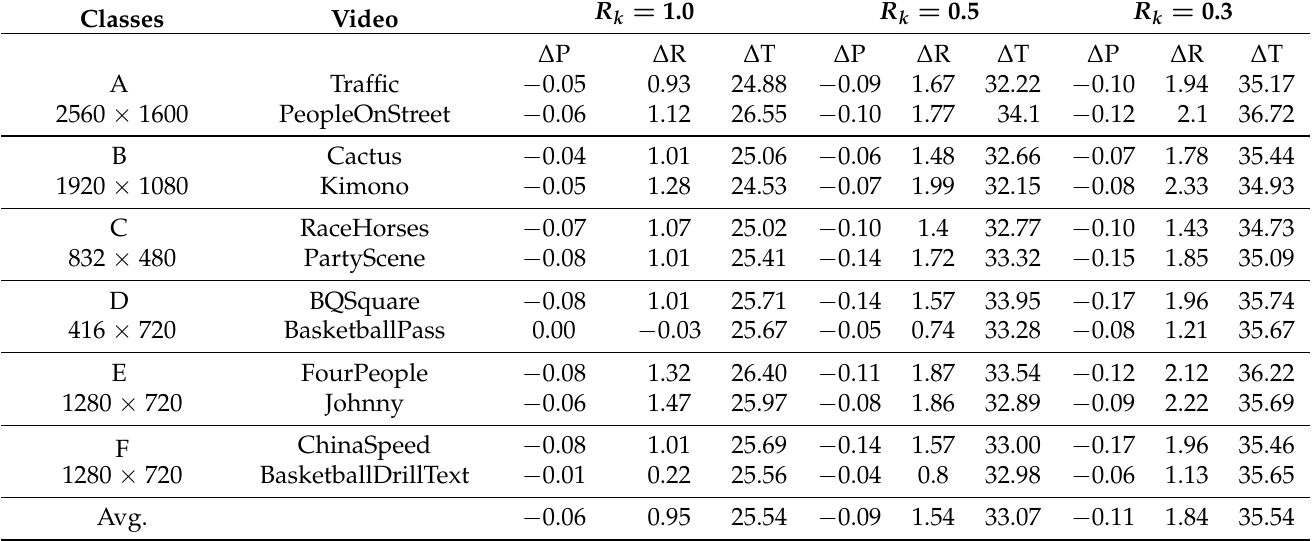
Table 1. Results of odds